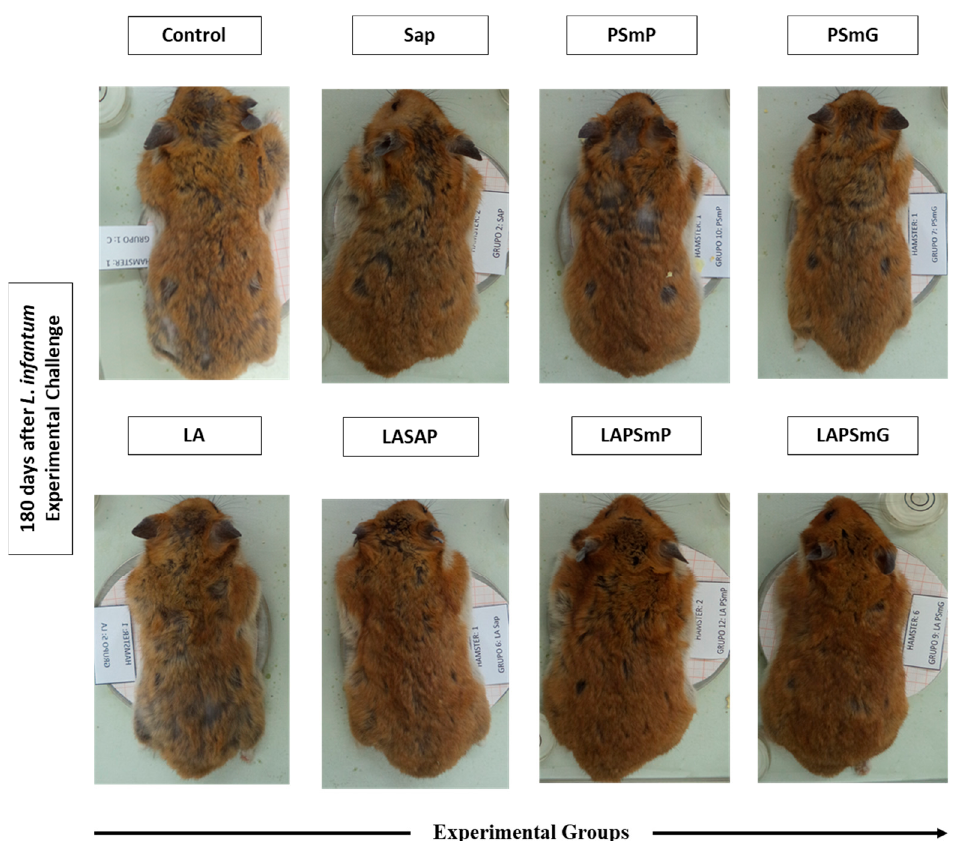
Figure 1. Macroscopic changes observed in the dorsal region of golden hamsters up to l the date of